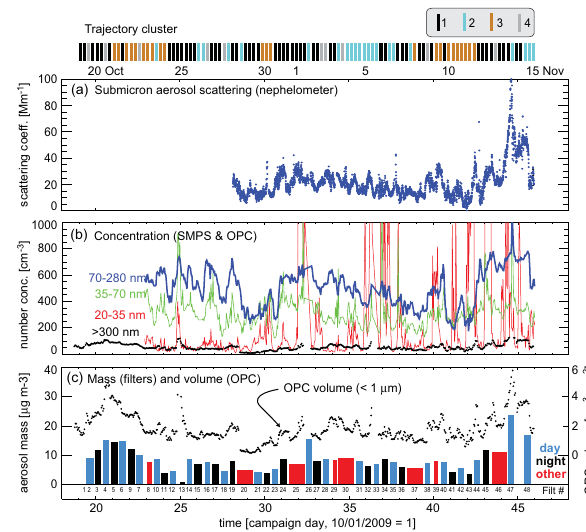
Fig. 3. Time series of (a) scattering coefficient for submicron aerosols from the nephelometer; (b) aerosol concentrations for the size ranges 20–35nm (nominally the nucleation mode), 35–70nm (nominally the Aitken mode), 70–280nm and > 300nm from the SMPS and OPC; (c) gravimetrically-derived aerosol mass loading (bars, left axis) and submicron aerosol volume from the OPC (right axis). The filters sampling times dictate the width of the bars, and the colors indicate whether the sample was taken during the day (sampling start time 06:00–12:00 h local, end time 17-23 hr local), night (sampling start time 17:00–23:00h local, end time 06:00– 12:00h local), or other (all other samples, mostly ones sampling an entire day). The filter number (corresponding to Table 1) is in- dicated below the bars. At the top of the figure is shown the trajec- tory cluster number for the back-trajectory classification presented in Sect.3.3 and shown in Fig.